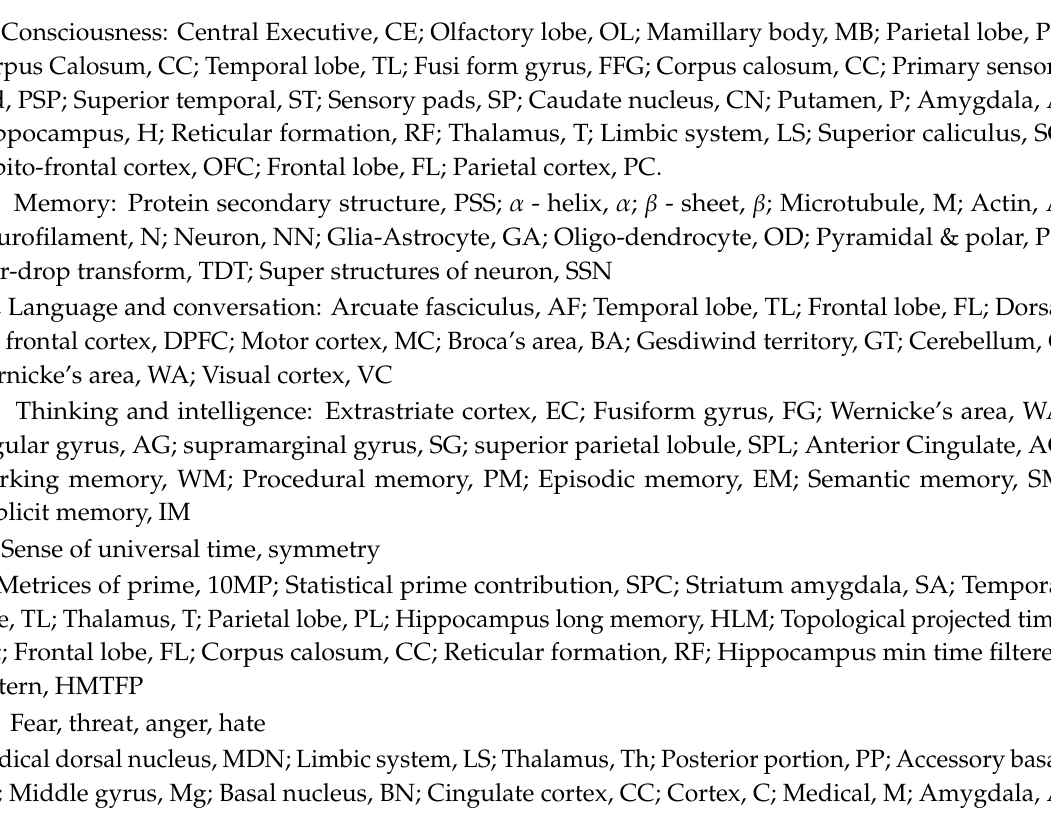
Figure 16. Garden of Garden’s (GOG) of time crystal [41]. Three tables show 12 dodecanion tensors that regulate fundamental conscious expressions of a human being, 8 octonion tensors that regulate sensory data integration and instantaneous decision making, 4 quaternions that senses the input data. Note that all data structure is 11D, or dodecanion, but they are packed like 4 linguistic questions.